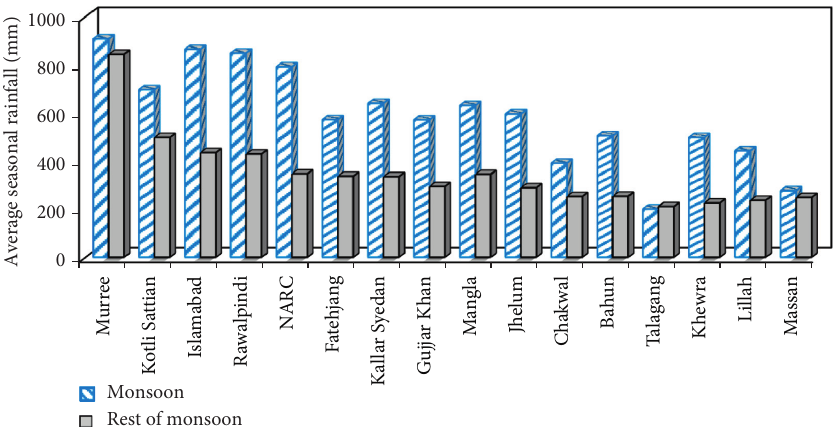
Figure 5: Monsoon and rest of monsoon rainfall